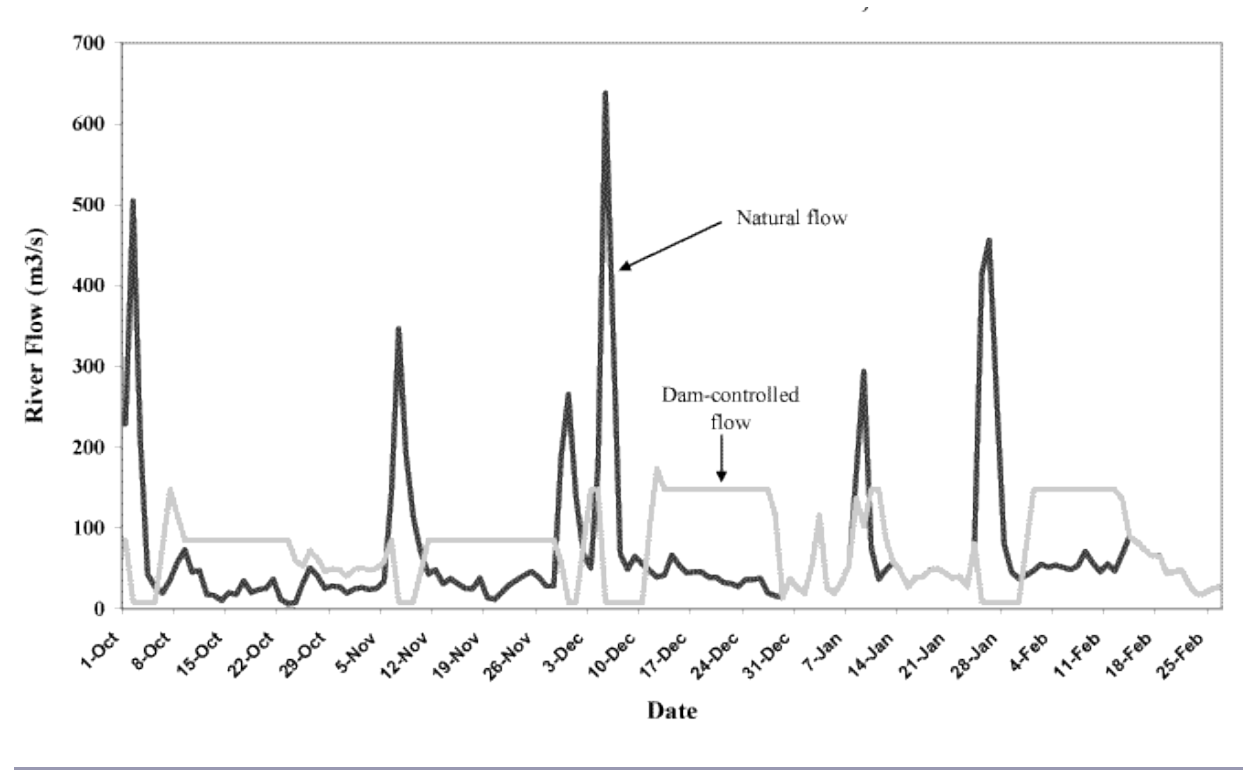
Fig. 1. Operation of a flood-control dam on the Green River in Kentucky, USA results in substantially lowered flood peaks, followed by extended high-flow releases of stored floodwater (based on 1978